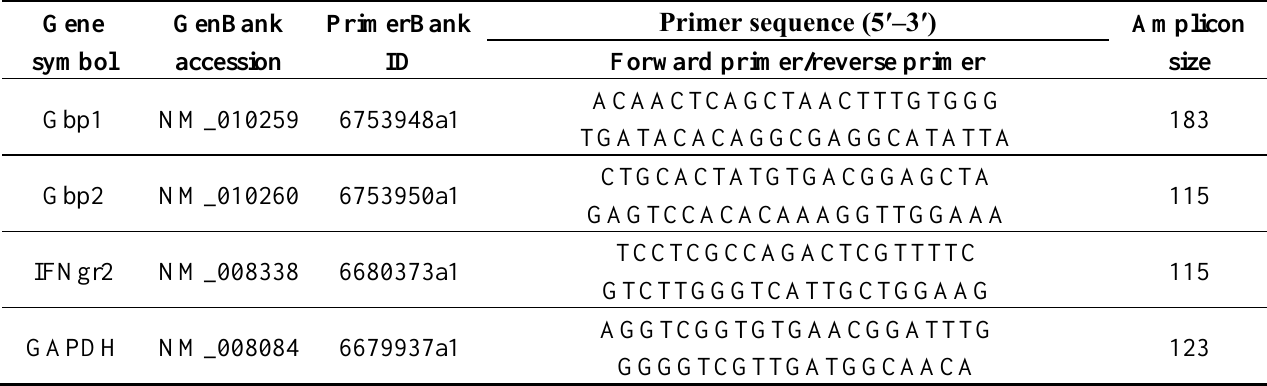
Table 2. Primer sequences used for QPCR